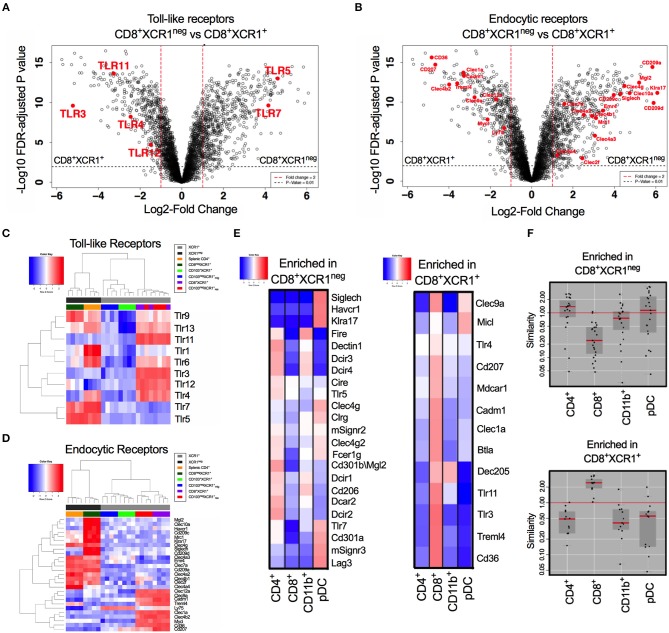
Differential expression of TLRs and endocytic receptors between CD8+XCR1neg and CD8+XCR1+ DCs. The expression of TLRs and endocytic receptors was compared between CD8+XCR1neg and CD8+XCR1+ DCs. Volcano plots show differential between CD8+XCR1neg and CD8+XCR1+ DCs. Red dashed line represents log2FC>1 and black dashed line represents adjusted p-value < 0.01. TLRs (A) and endocytic receptors (B) are highlighted in red. Heatmaps of gene expression comparing expression of TLRs 1-13 (C) and endocytic receptors (D) across the DC subsets in the microarray. (E) TLRs and CLRs enriched in either CD8+XCR1neg or CD8+XCR1+ DCs were compared to expression profiles of known DC subsets from the Immgen database using online tools. Red; up-regulated, Blue; down-regulated. (F) W-Plots summarize the relatedness of TLR and CLR profiles for CD8+XCR1neg and CD8+XCR1+ DCs obtained from microarray data to specific Immgen populations.